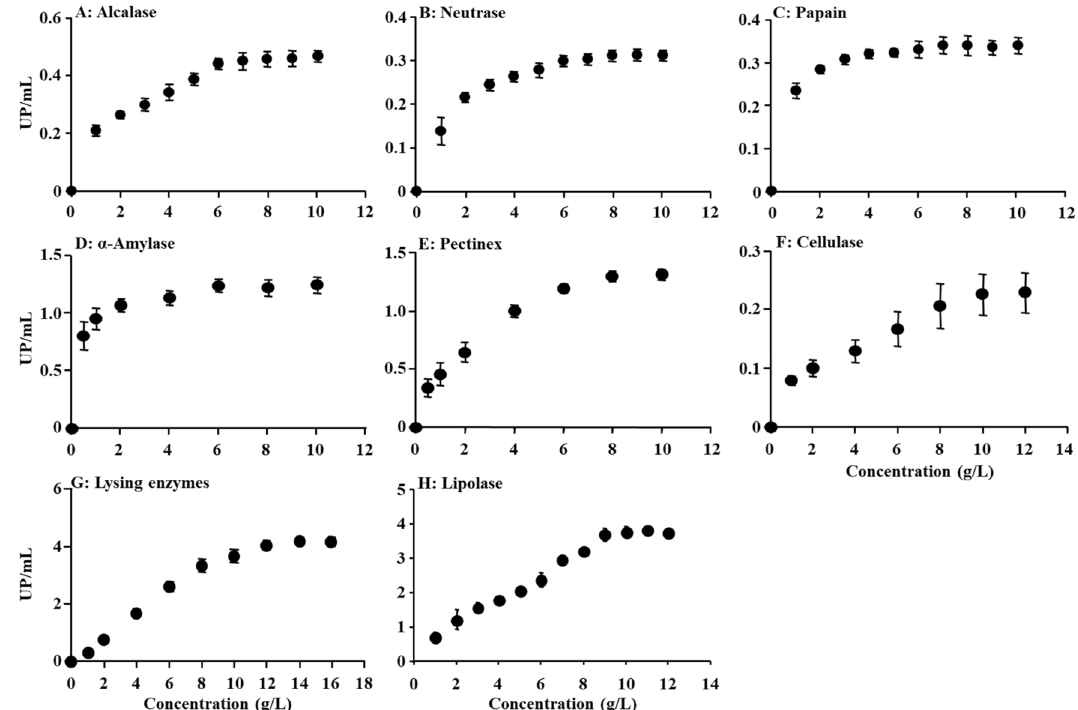
Figure 1. The activity of proteases, glycosidases and lipase in different